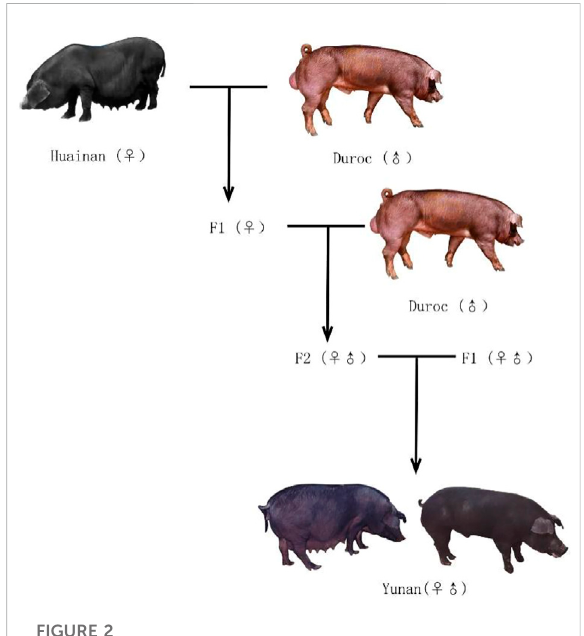
FIGURE 2 Schematic representation of the setup to generate Yunan using Huainan and